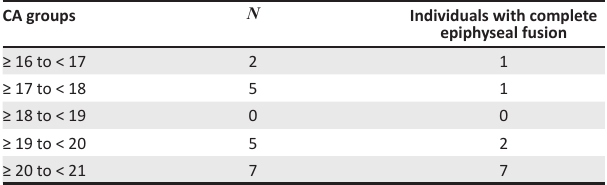
TABLE 5: The number and percentage of skeletally mature male patients per chronological age group. CA groups